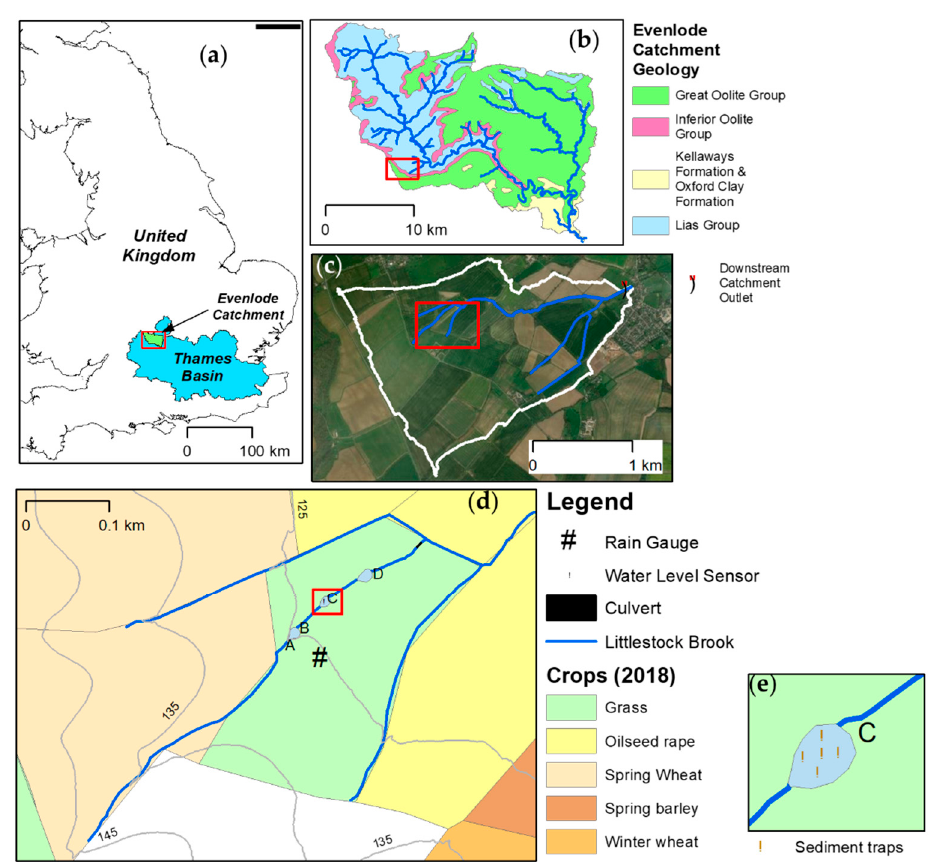
Figure 1. Locations of ( a ) the Evenlode catchment (green) within the Thames basin (blue); ( b ) the Downstream Catchment (outlined in red) within the Evenlode catchment and its geology; ( c ) the field site of the on-line ponds (outlined in red) within the Downstream Catchment; ( d ) the on-line ponds and monitoring sites (labelled A-D from upstream to downstream) and ( e ) sediment traps within the Central Pond. The white field contains improved grassland used as a horse paddock. Contours (grey) display elevation (metres AODN). Crop data are from UKCEH Land Cover ® plus : Crops (2018).